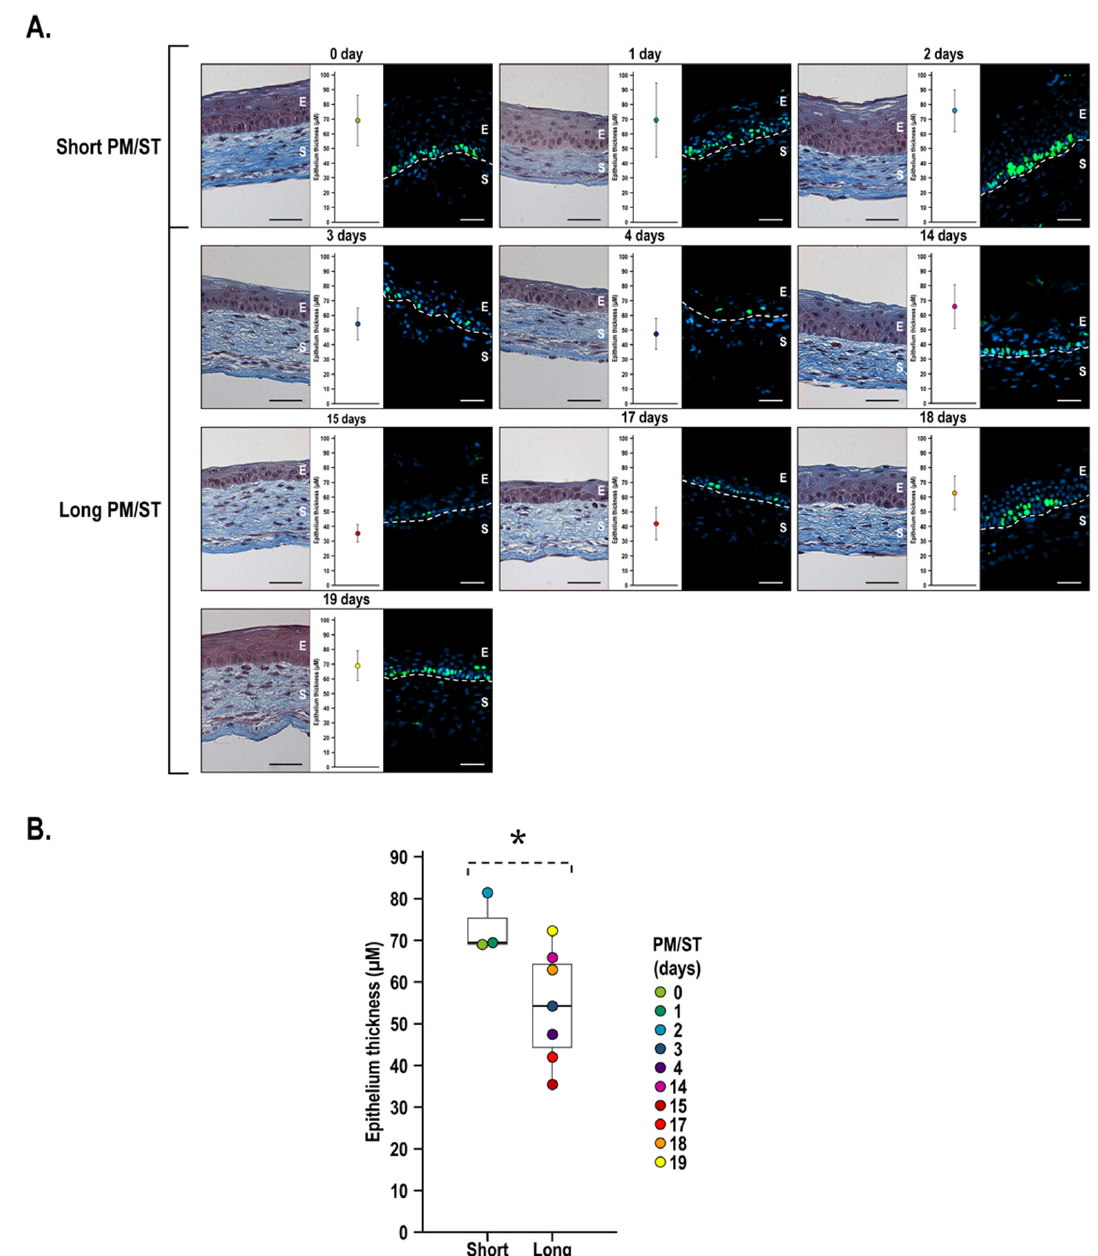
Figure 5. Analysis of morphology and thickness of the stratified corneal epithelium when short and long PM/ST hLECs are used to produce human-tissue-engineered corneas (hTECs). Human-tissue-engineered corneas (hTECs) were reconstructed by seeding hLECs with various PM/STs over reconstructed stroma to produce a 3D construct. ( A ) Histology (Masson’s trichrome staining), epithelium thickness ( µ m), and Ki-67 (immunofluorescence) analyses of SPM/ST hTECs (short PM/ST: 0, 1, and 2 days) and LPM/ST hTECs (long PM/ST: 3, 4, 14, 15, 17, 18, and 19 days). ( B ) Graph of mean epithelium thickness of SPM/ST hTECs (short) and LPM/ST hTECs (long). E: epithelium; S: stroma. Scale bars: 50 µ m. p -value: * < 0.08.